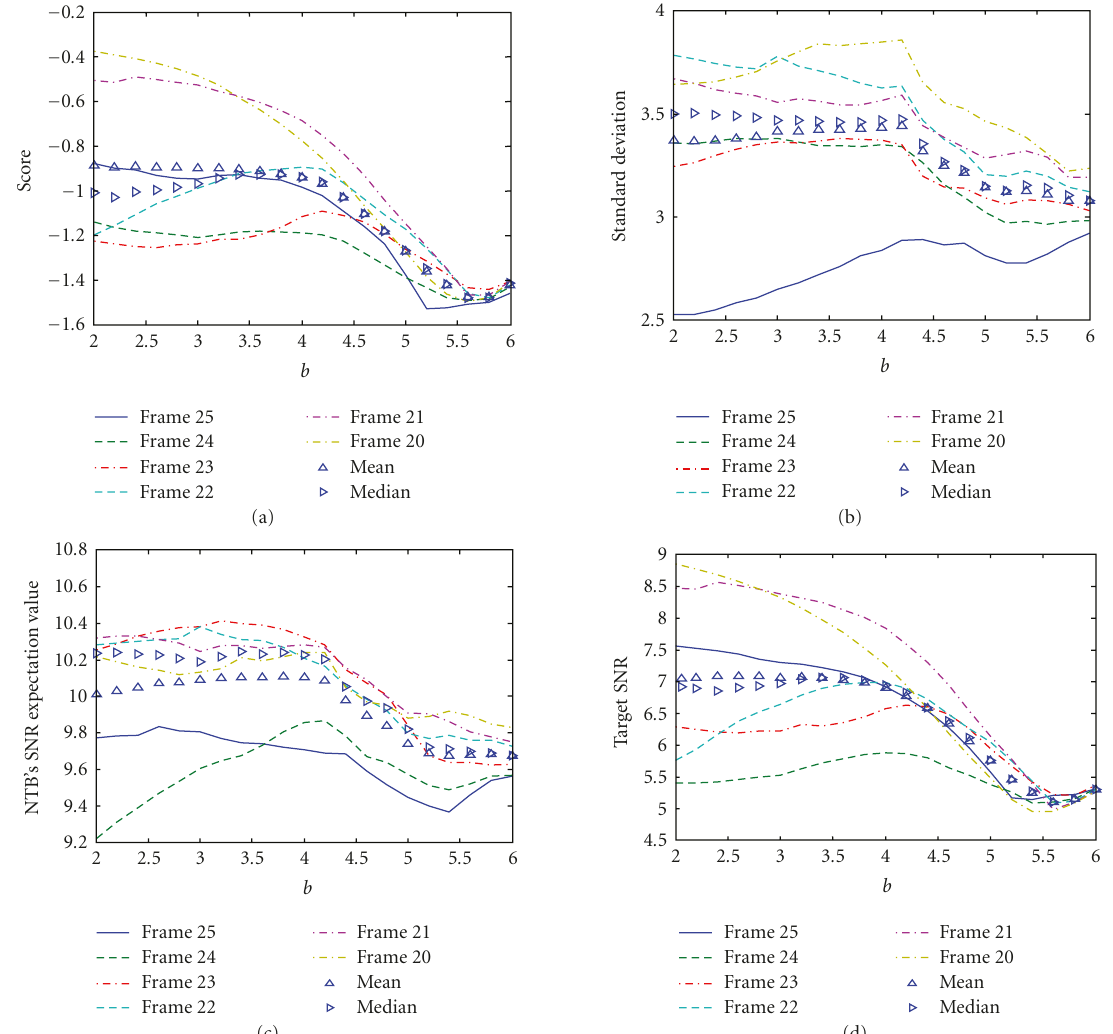
Figure 22: NPA sequence, s n = 3. (a) A S, g = 0, Max Numbers = 3, (b) STD of NTB’s SNR, (c) expectation value of NTB’s SNR, and (d) TB’s SNR.